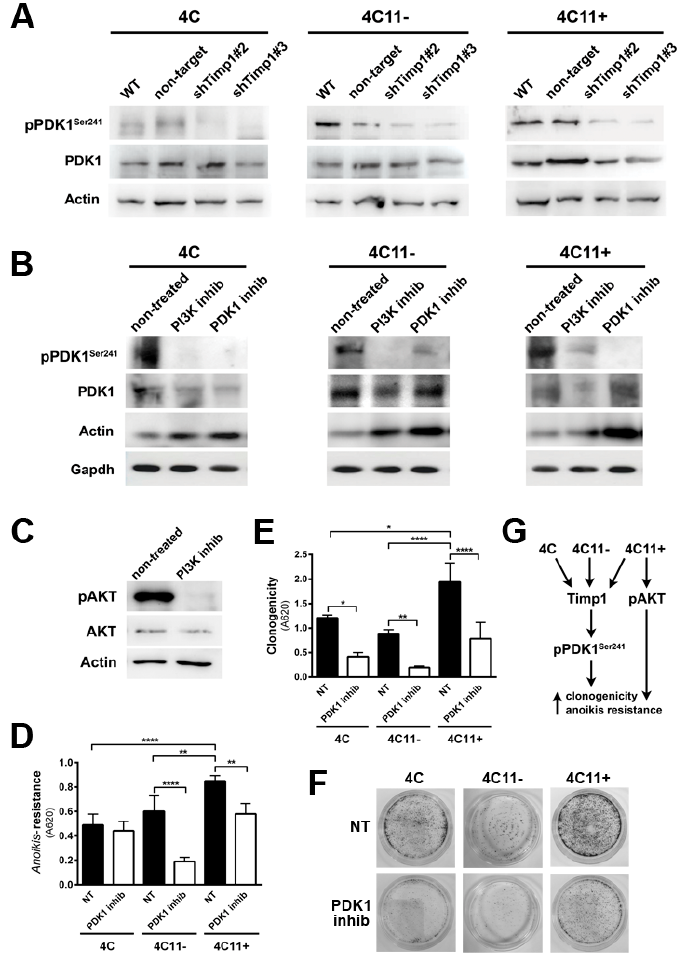
Figure 4. PDK1 is activated by Timp1, along with melanoma progression, and contributes to cell survival. ( A ) PDK1 activation was examined in cell lines 4C, 4C11 − , and 4C11+ and their Timp1-silenced clones. Total PDK1 and β -actin were used as loading controls. WT: non-treated cells; non-target: control non-target shRNA; shTimp1#2: clone 2 silenced for Timp1; shTimp1#3: clone 3 silenced for Timp1; ( B ) cell lines treated with LY294002 (PI3K inhibitor), GSK2334470 (PDK1 inhibitor), and Bisindolylmaleimide I (PKC inhibitor) were analyzed for PDK1 activation by Western blotting. Total PDK1, β -actin (Actin), and GAPDH were used as loading controls; ( C ) 4C11+ metastatic melanoma cells treated or not with LY294002 (PI3K inhibitor) were analyzed for AKT activation by Western blotting. β -actin was used as a loading control; ( D ) cell lines non-treated (NT) or treated with GSK2334470 (PDK1 inhibitor) were evaluated for anoikis resistance after maintained in suspension for 96 h; ( E , F ) colony formation capacity was determined in cell lines non-treated (NT) or treated with GSK2334470 (PDK1 inhibitor); and ( G ) cell lines corresponding to both early (4C and 4C11 − ) and late (4C11+) stages of melanoma progression confer cell survival via Timp1 by activating PDK1 pathway. In metastatic cell line (4C11+), AKT also contributes to anoikis resistance. * p < 0.05, ** p < 0.01, *** p < 0.001.